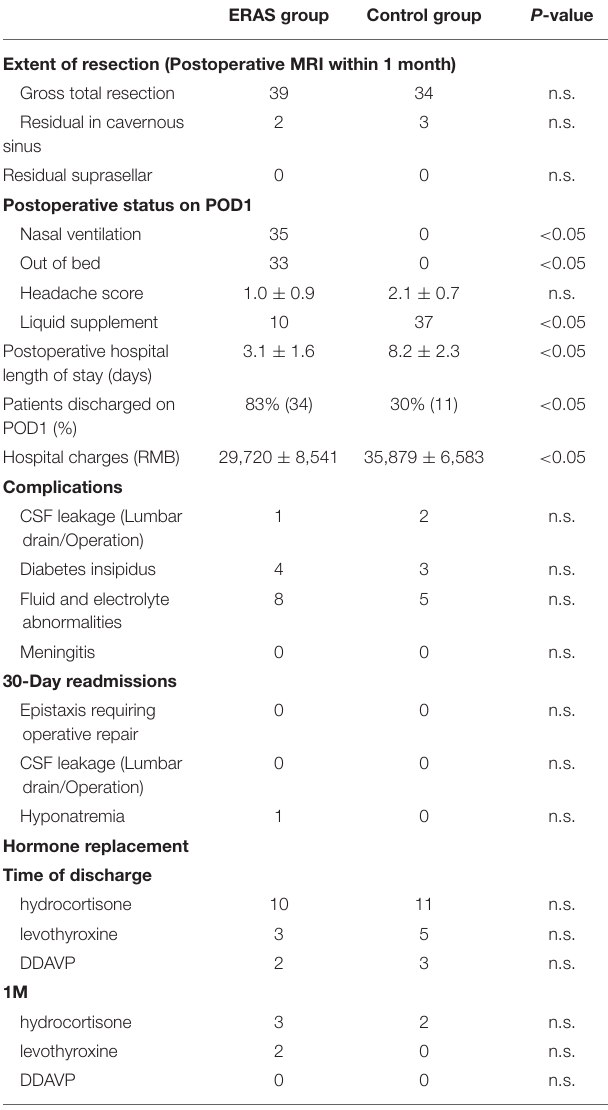
TABLE 3 | Early postoperative